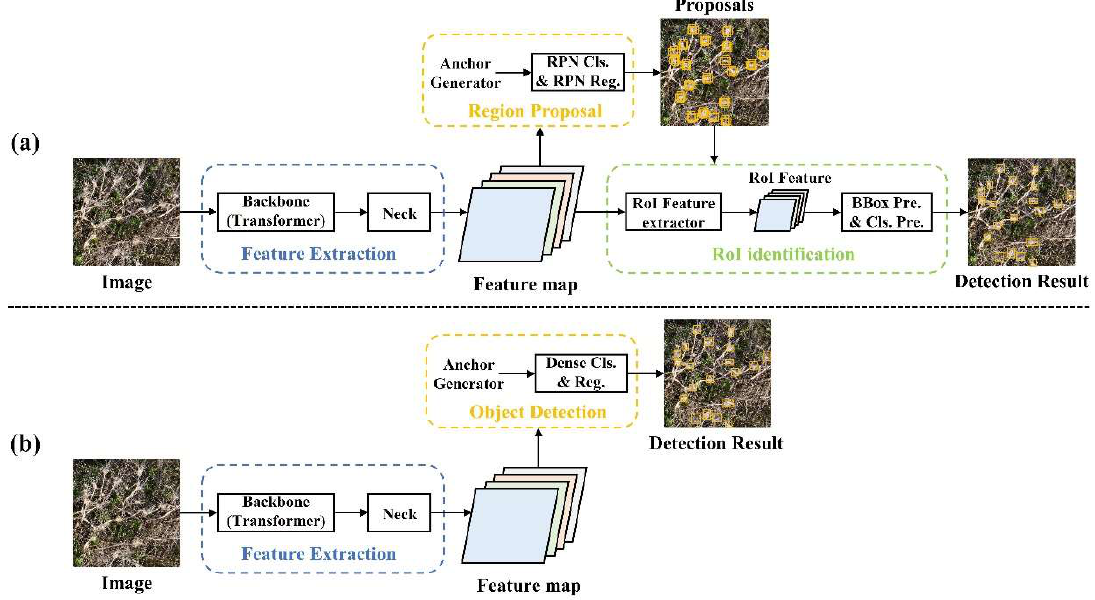
Figure 5. Wheat head Transformer detection method. Two-stage method FR-Transformer ( a ); one- stage method R-Transformer and one-stage method Y-Transformer ( b ).